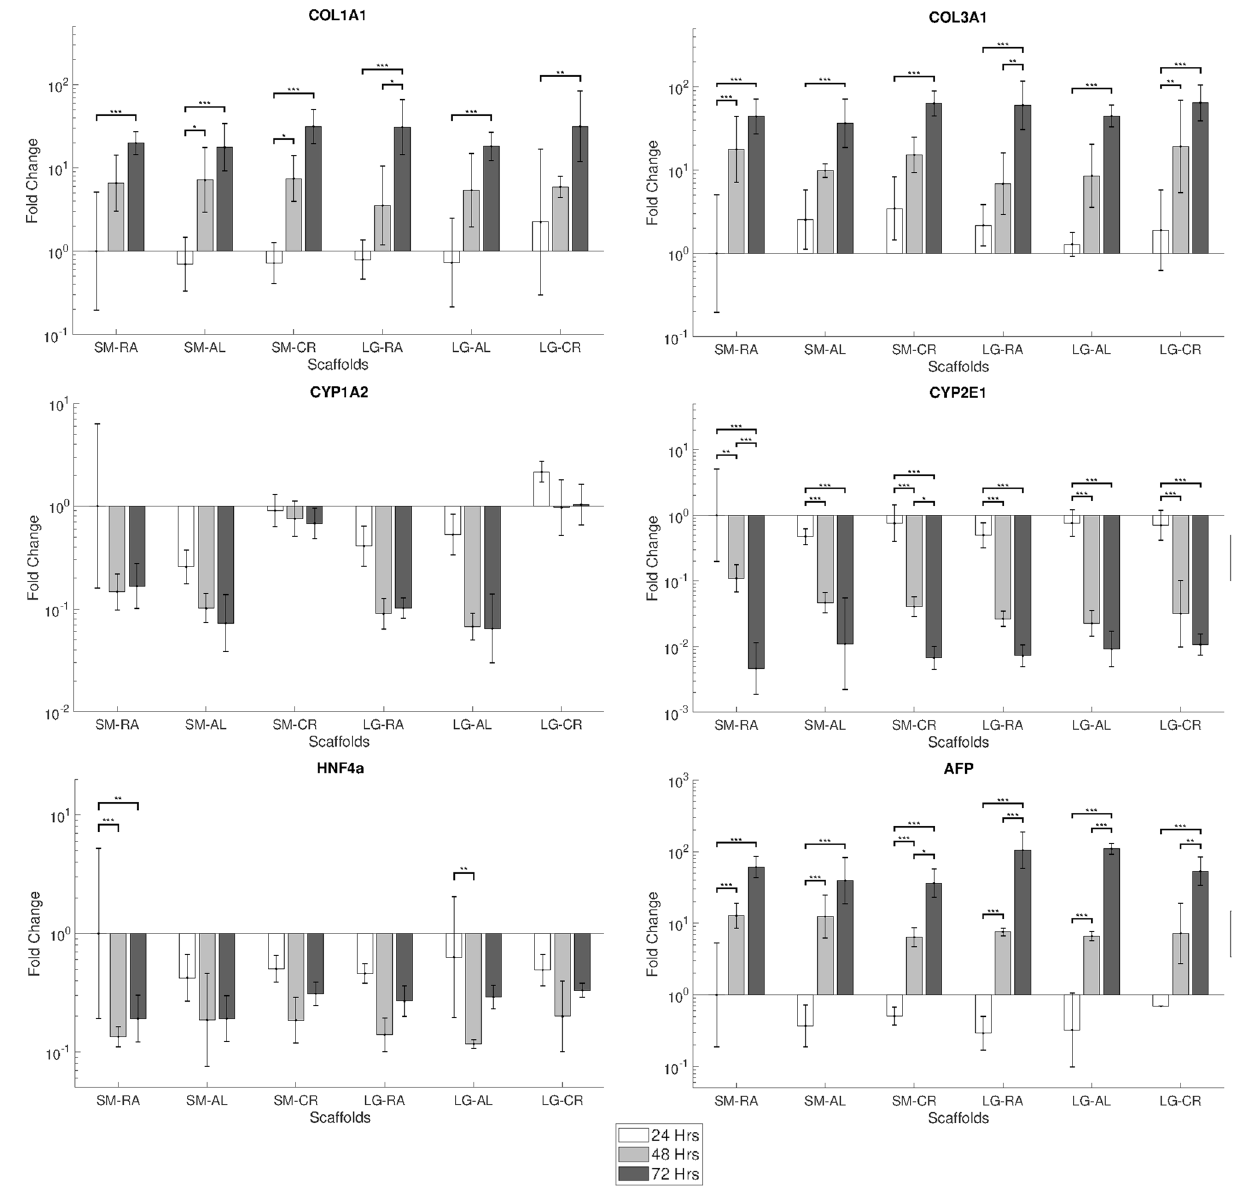
Figure 7. RT-qPCR gene expression results showing fold change of COL1A1, COL3A1, AFP1, HNF4a, CYP1A2 and CYP2E1 for MPHs over 3 days. Results normalised to MPHs on SM.RA at 24 h. N ≤ 5, Error bars = SD and *p < 0.05, **p < 0.01 and ***p <